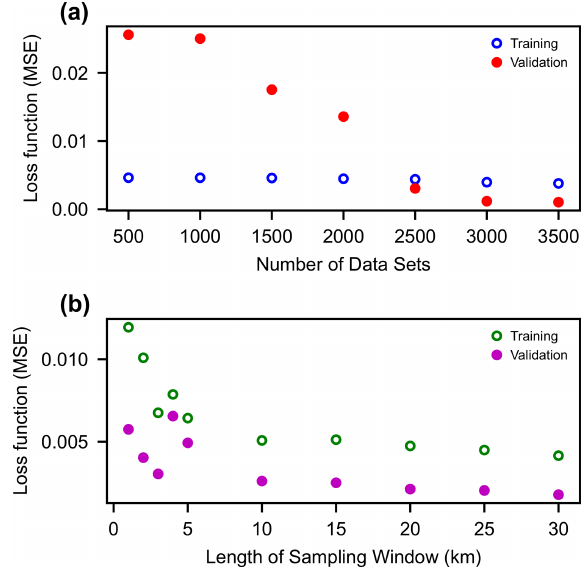
Figure 4. Examples of turbidites calculated by the forward model. (a) Spatial distributions of bed thickness. Four beds (beds 1–4) were plotted as examples. (b) Spatial distribution of the volume per unit area for each grain size class in bed 1 (Fig. 4a).